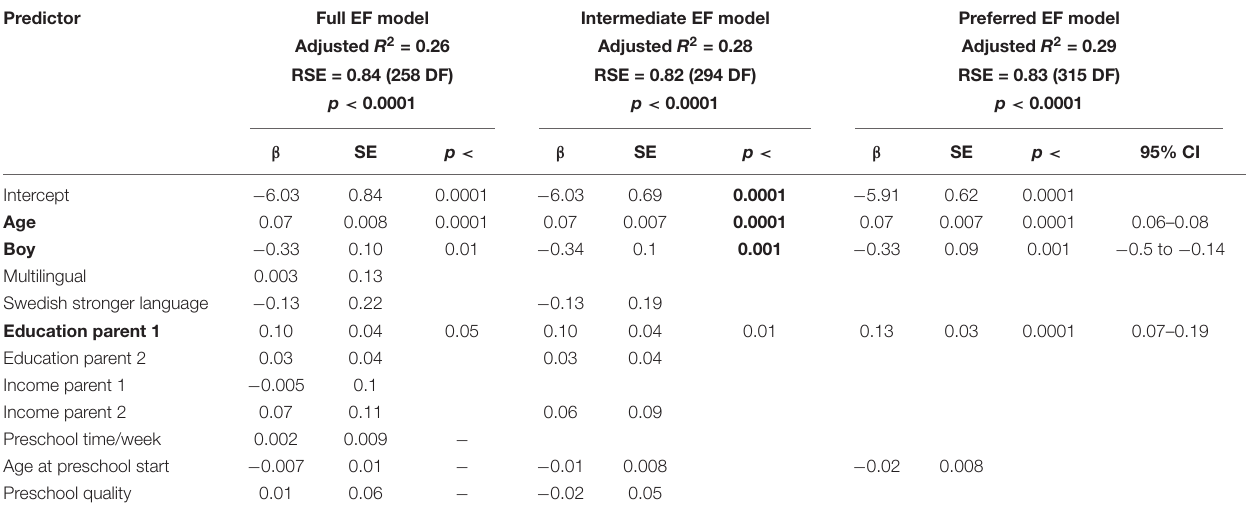
TABLE 5 | Model comparison for EF score.